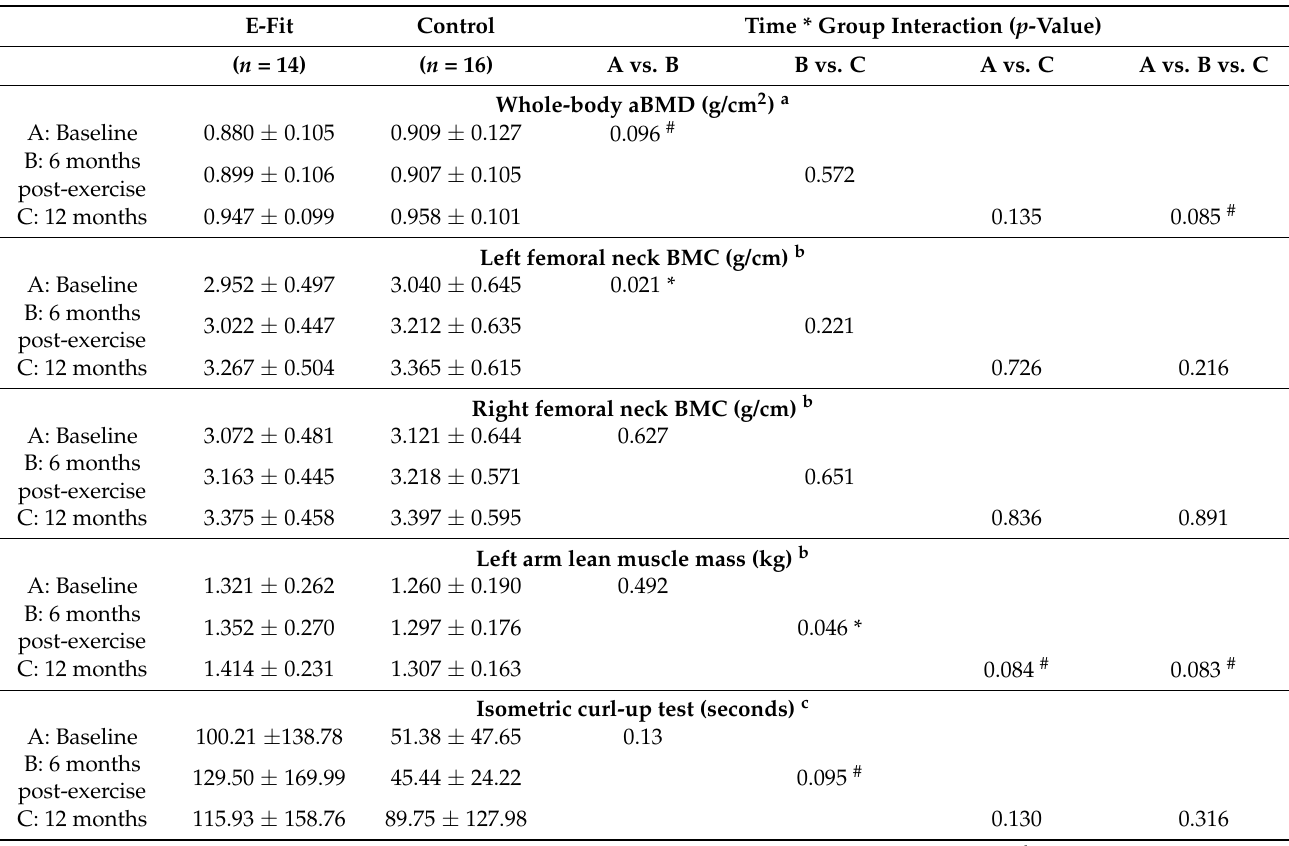
Table 2. The means of bone mineral density, bone mineral content, and muscle endurance measures over time of the subjects. E-Fit Control Time * Group Interaction ( p